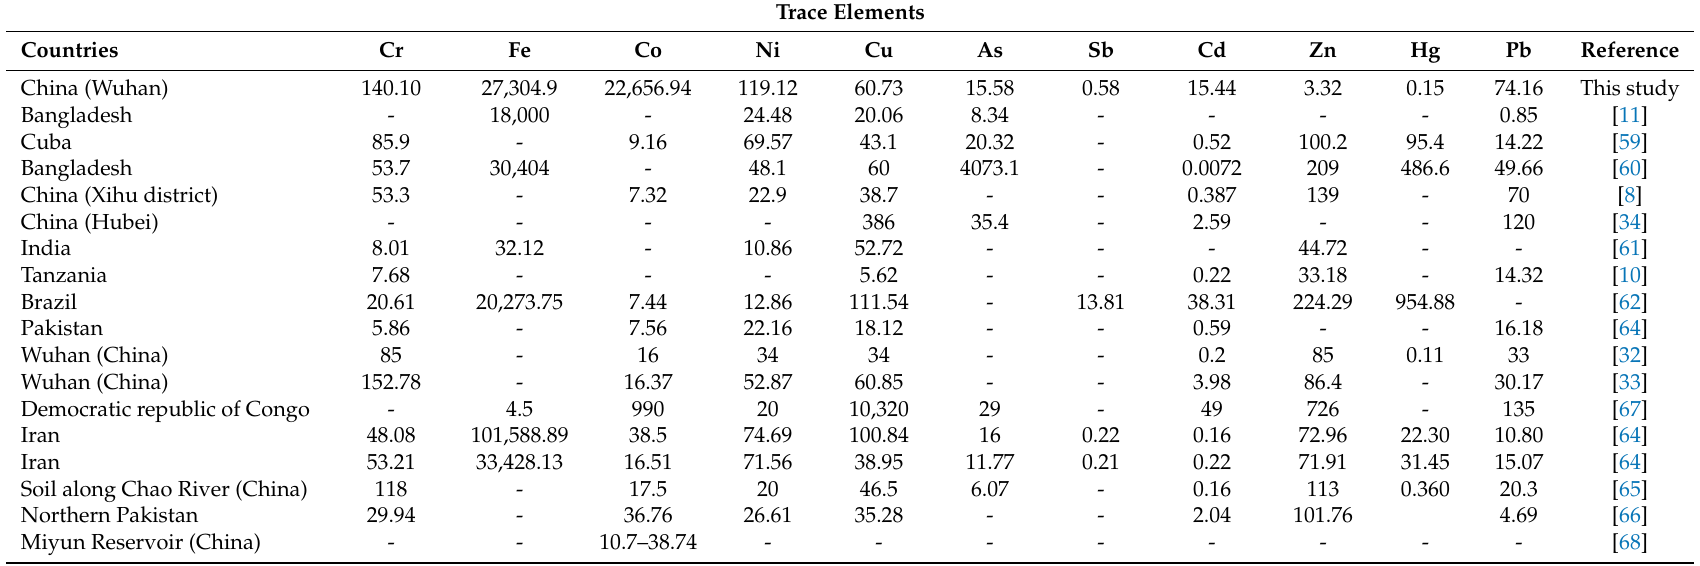
Table 4. Comparison of the median concentrations (mg/kg) result of trace elements for this study with the other